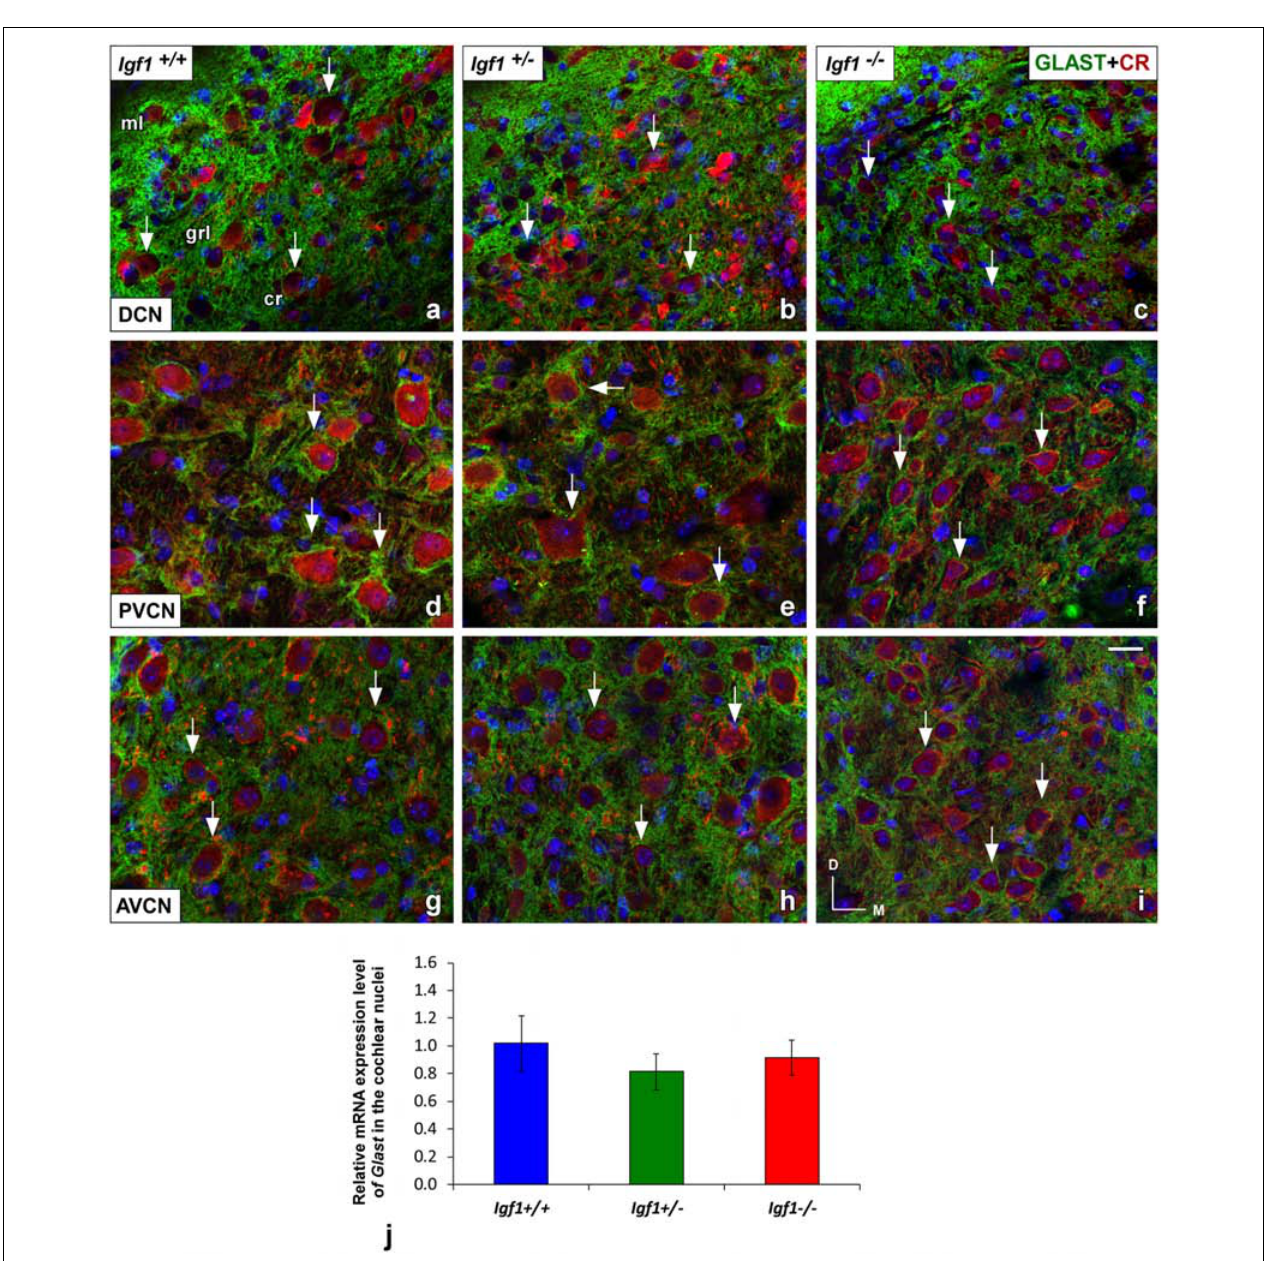
FIGURE 9 | Glutamate aspartate transporter (GLAST) immunostaining in the Igf1 − / − mice cochlear nuclei. In all genotypes, GLAST stained puncta (green) were densely distributed throughout the neuropil and on the soma of DCN (A–C) , PVCN (D–F) and AVCN (G–I) neurons immunostained with CR (red). No differences were observed in the distribution of the immunostaining among the three groups. The analysis of Glast expression levels by RT-qPCR confirmed these immunohistochemical results (J) . The error bars indicate the standard deviations of the mean. Arrows point to CR-immunostained cells. Cell nuclei are stained with DAPI (blue). Abbreviations: AVCN, anteroventral cochlear nucleus; cr, central region of the DCN (dorsal cochlear nucleus); CR, calretinin; GLAST, glutamate aspartate transporter; grl, granule/fusiform layer; ml, molecular layer; PVCN, posteroventral cochlear nucleus. Scale bar: 20 µ m in ( I ; it also applies to A–H